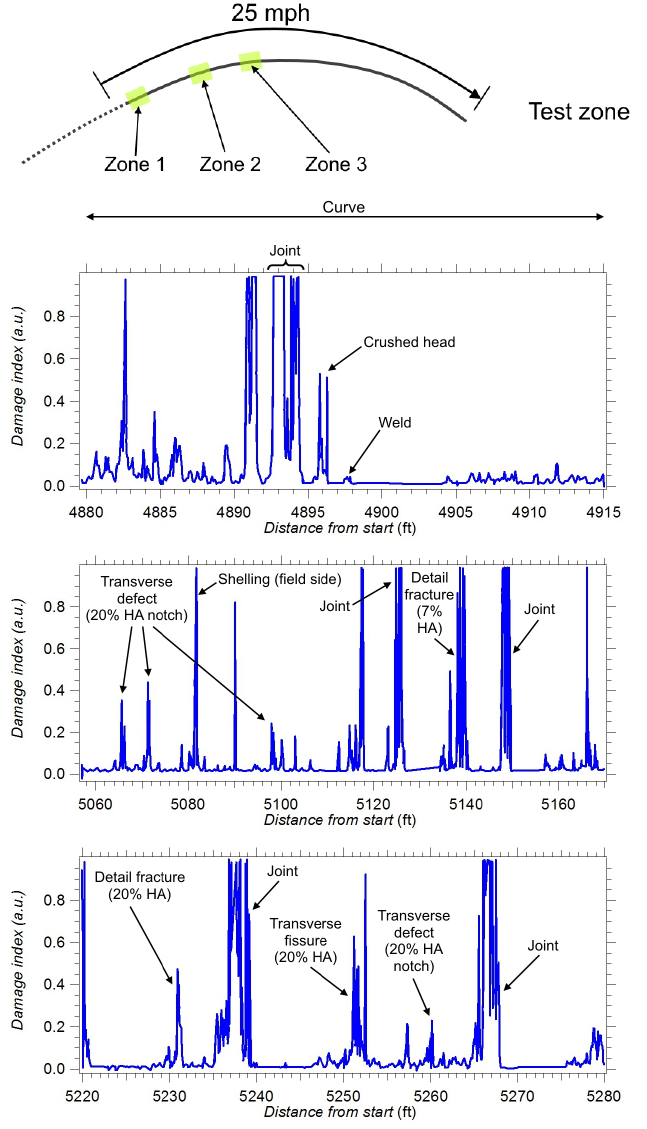
Figure 24. Damage index traces referring to the RDTF test track at 25 mph (40 km/h) in three selected test